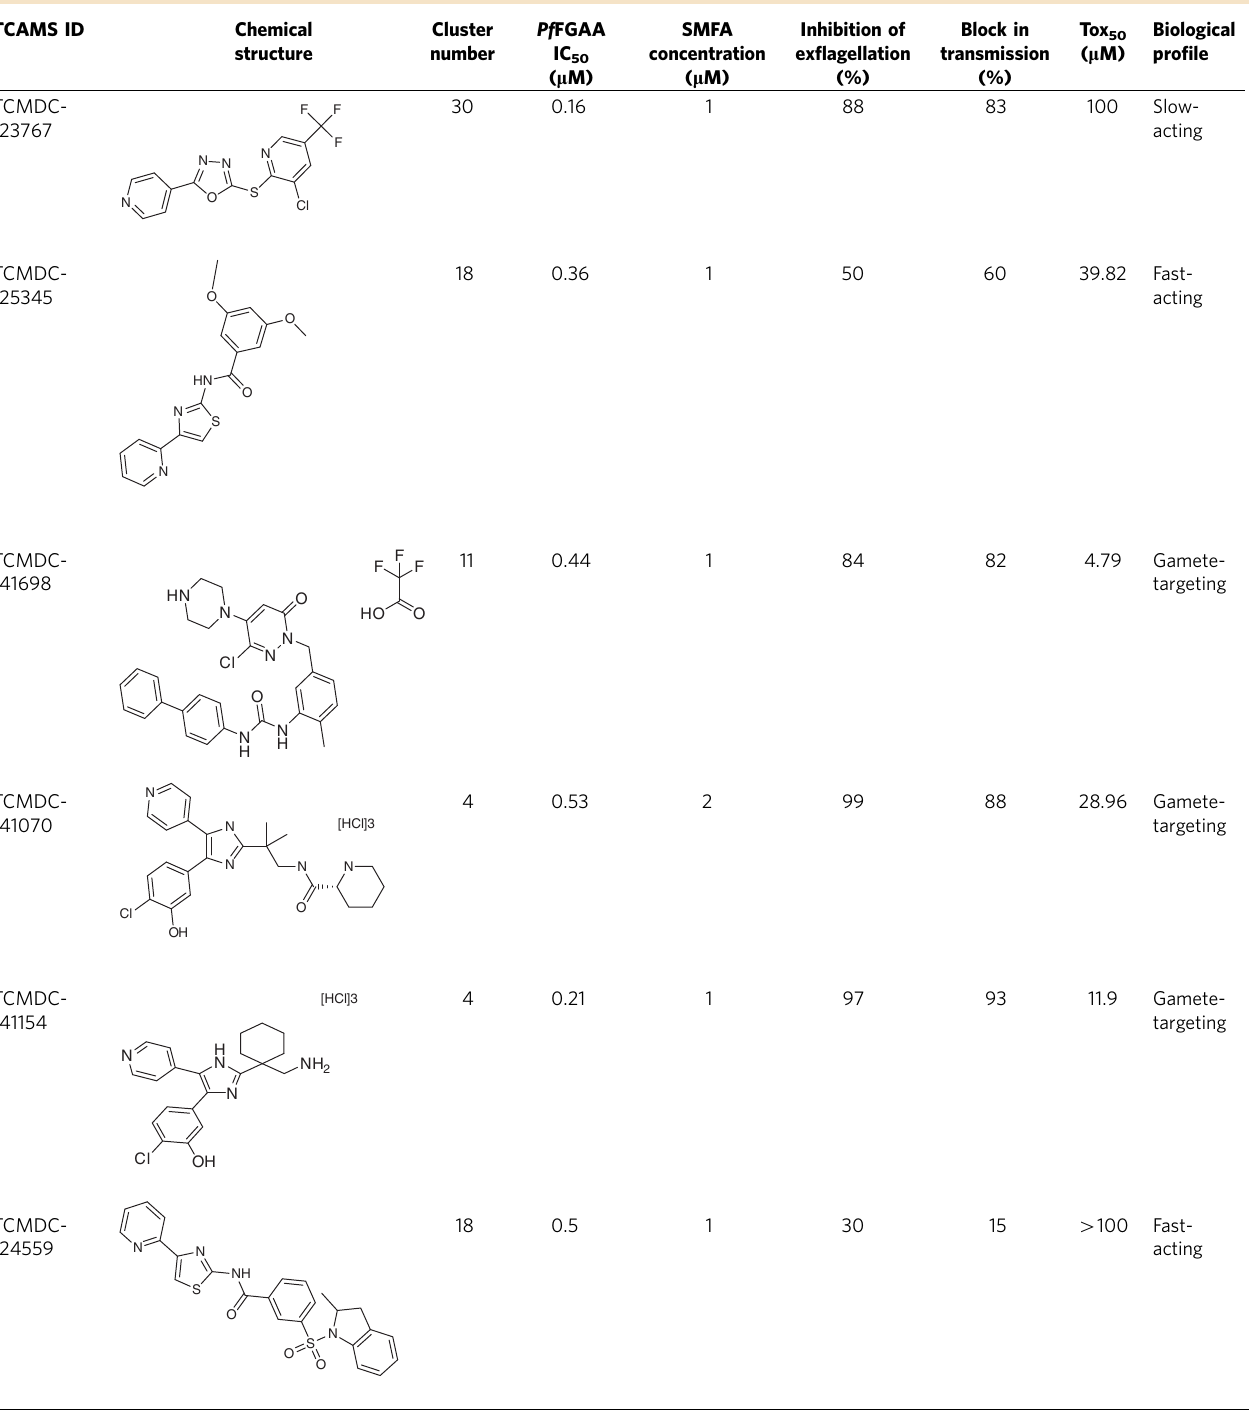
Table 1 | Biological and chemical profile of the six compounds tested in the SMFA. TCAMS